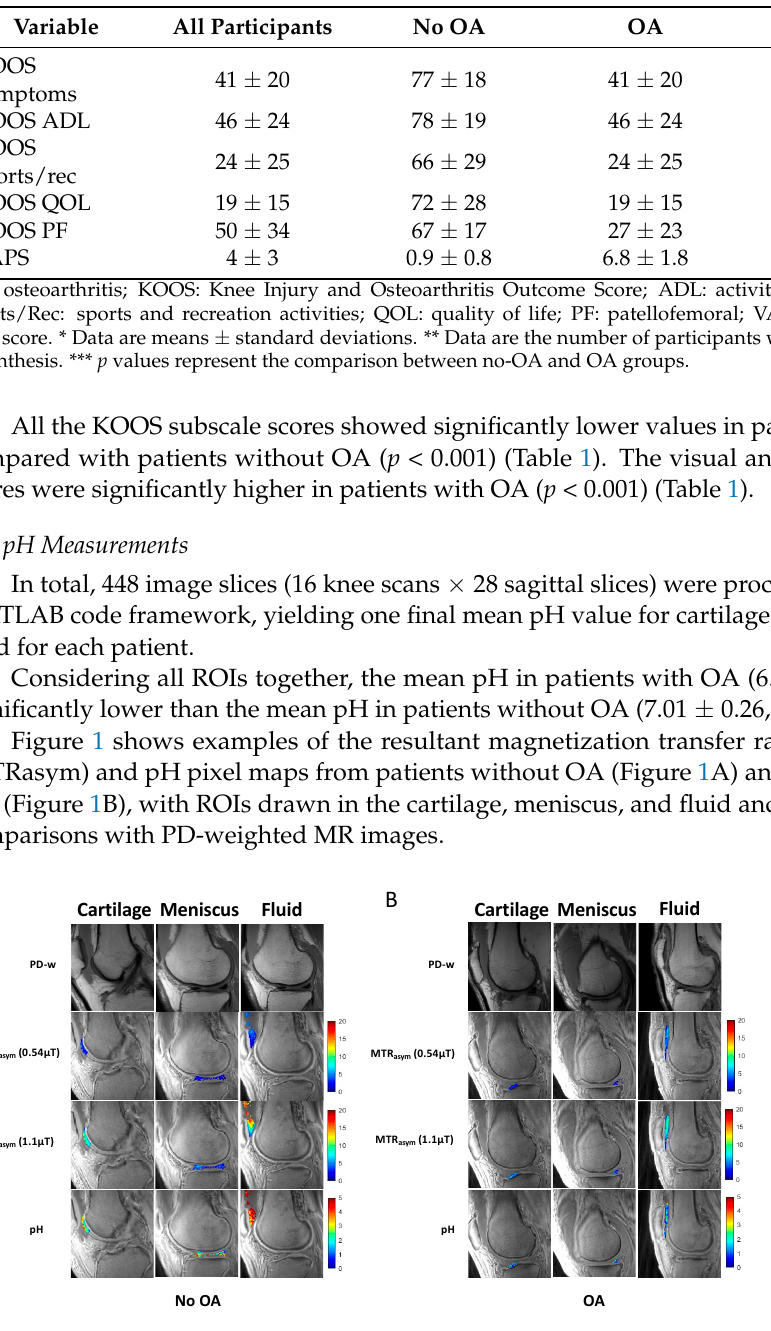
PD-weighted (first row), low-power acido-CEST UTE (second row), high-power acido-CEST UTE